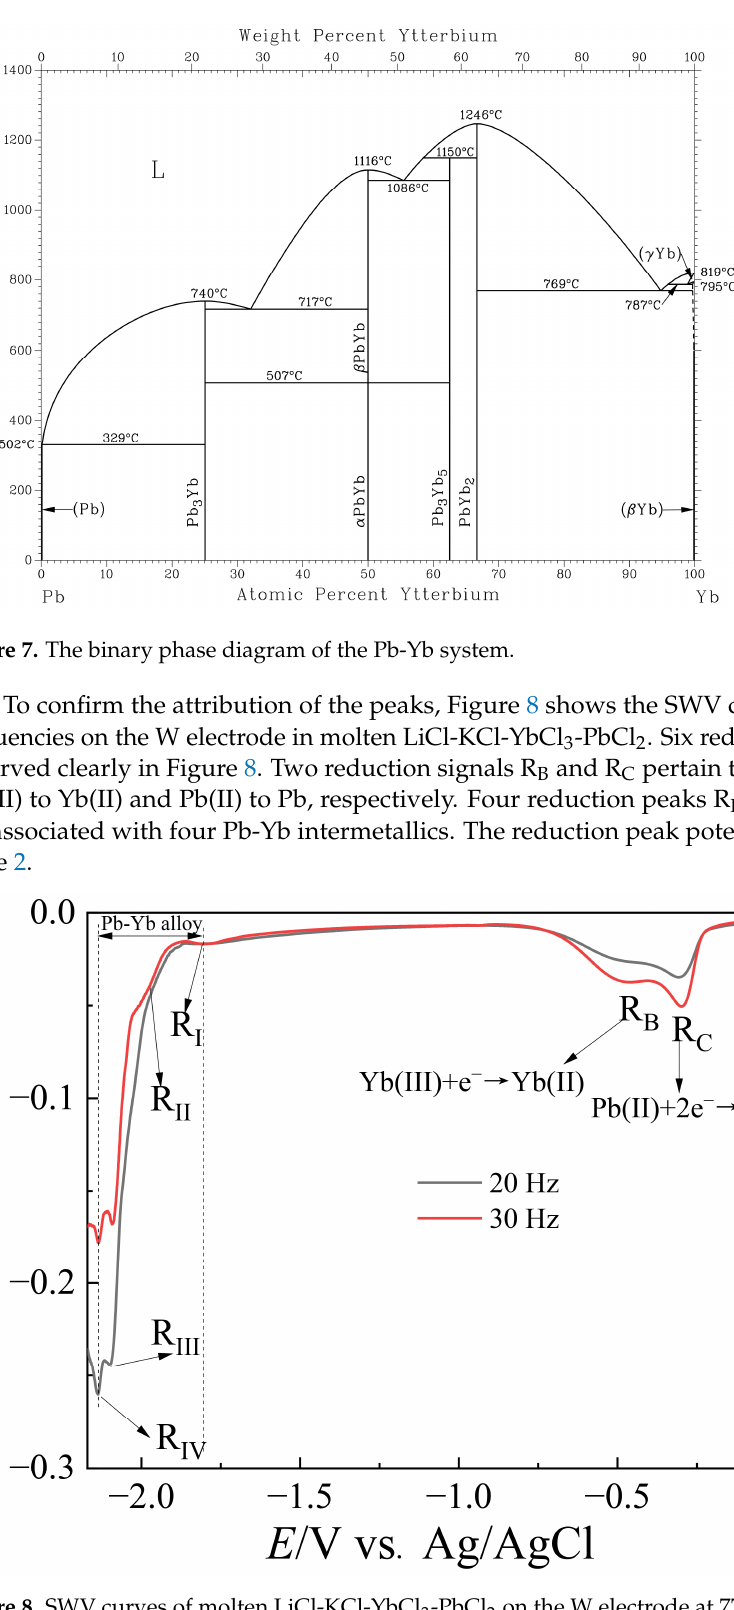
Figure 6. CVs of blank eutectic LiCl-KCl (black line) and molten LiCl-KCl-YbCl 3 -PbCl 2 salts (red line) on the W electrode at 773 K.